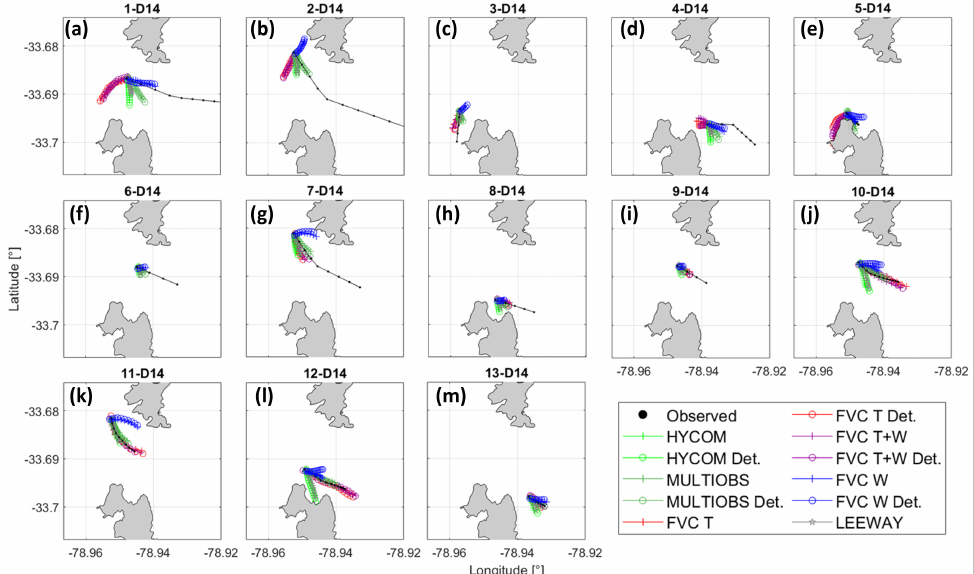
Figure 11. Geographic comparison between measured and modeled drifters with best NCLS mod for 14 September 2011. ( a – m ) Drifter deployments 1–13, respectively, as indicated in Figure 9b. Panel titles indicate drifter deployment number (X-D14, where X is drifter number). FVC = FVCOM; T = Tide; W = Wind; Det. = deterministic (drag force)